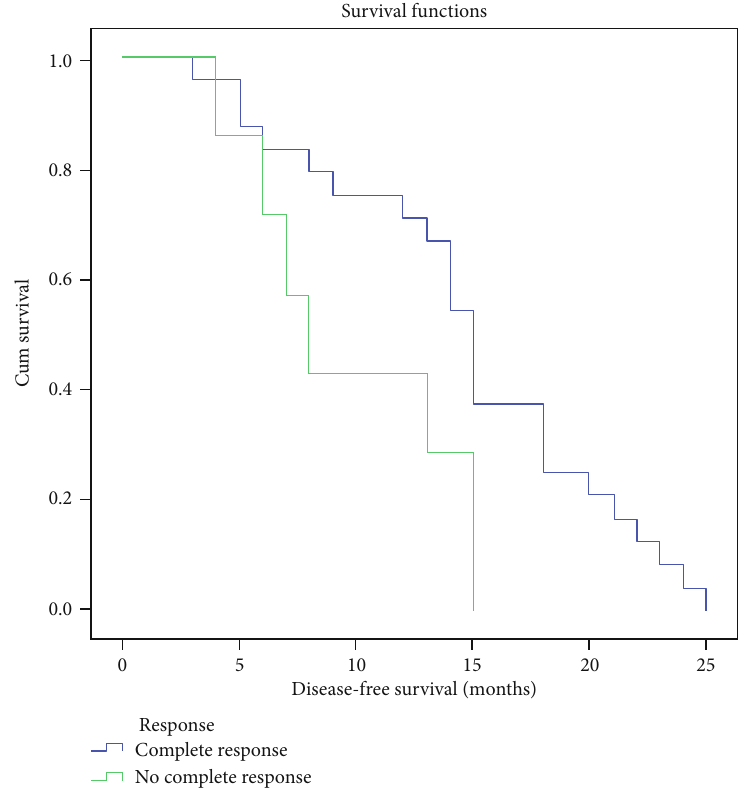
Figure 10: DFS for di ff erent response groups of B-cell